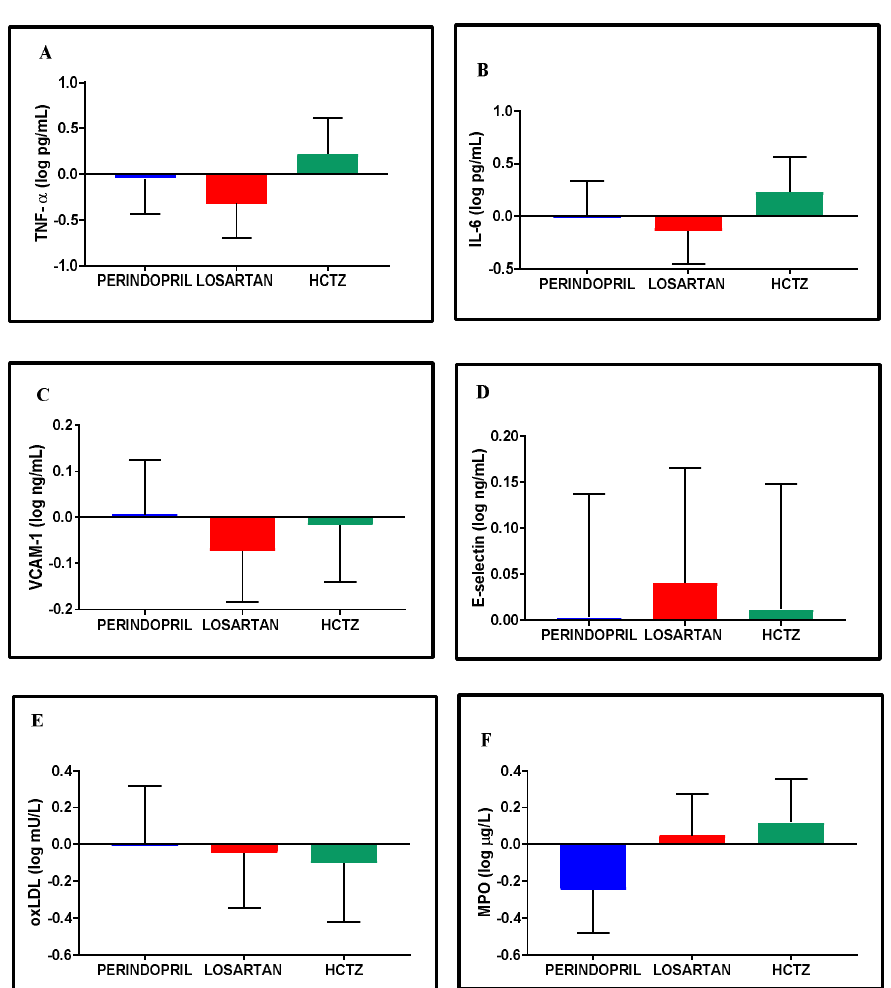
Figure 6. Adjusted mean change within groups in inflammatory ( A–D ) and oxidative stress biomarkers ( E , F ) from baseline to 24-week follow-up. Data are expressed as adjusted mean change within groups with 95% confidence intervals adjusted to age, sex, and baseline status. Log-transformation was used to normalize data distribution (Shapiro-Wilks test, p < 0.05). IL-6: Interleukin-6; MPO: Myeloperoxidase; oxLDL: Oxidized LDL; TNF- α : Tumor necrosis factor- α ; VCAM-1: Vascular cell adhesion